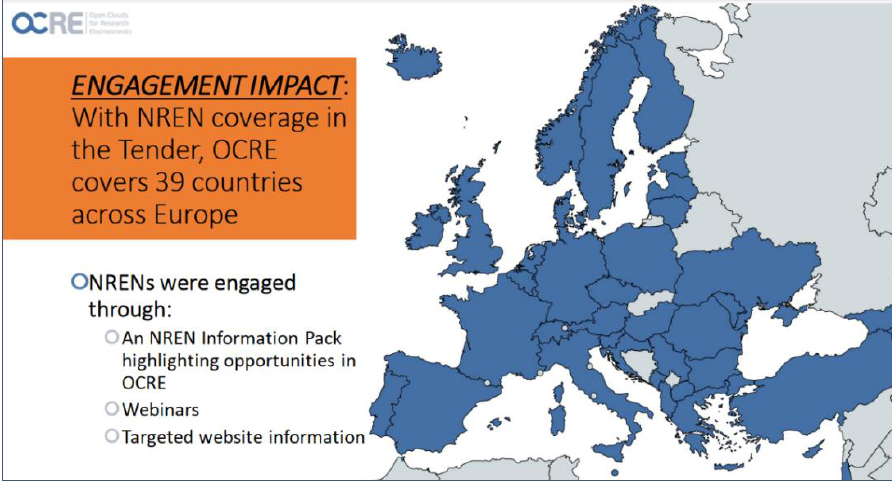
Figure 2. Geographical distribution of registered NREN in